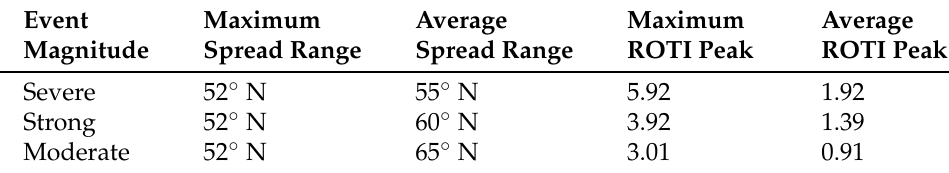
Table 5. Typical and maximum features of storm-induced ROTI spread.